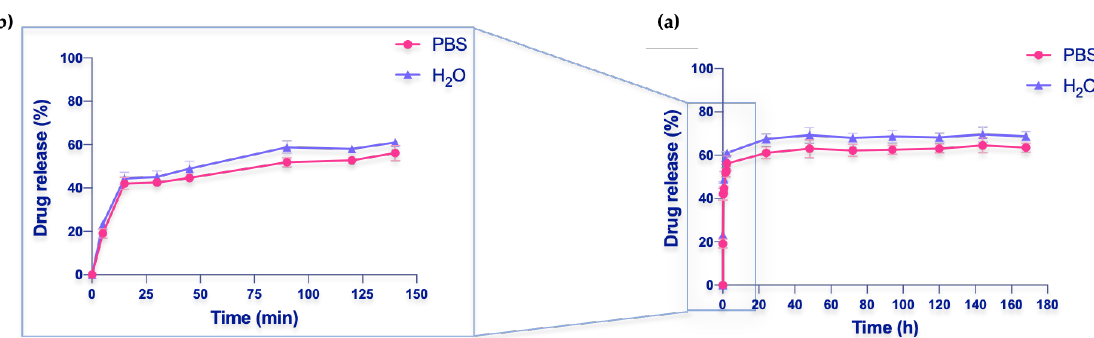
Figure 6. ( a ) Thy release (%) from HEMA-HNT/Thy in one week. ( b ) Enlargement of Thy release (%) in the first 140 min.